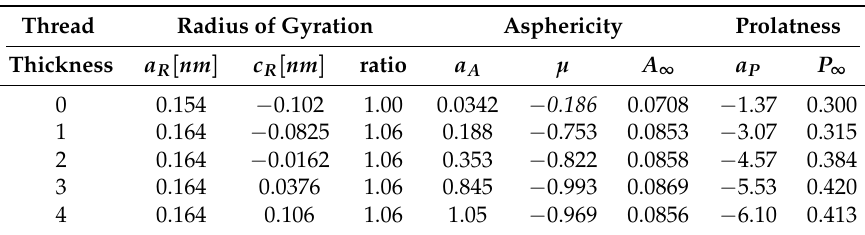
Table 1. Parameters fitted for the shape parameters scaling as the function of the thread thickness. The “ratio” is the value of the preexponential factor compared with the case of unthreaded loop a r ( thickness = n ) / a r ( thickness = 0 ) . The scaling factor for the asphericity for the unthreaded loop was given in italic as it stands out from the trend and the fitting error obtained in this case was significant (see Section S3 in Supplementary